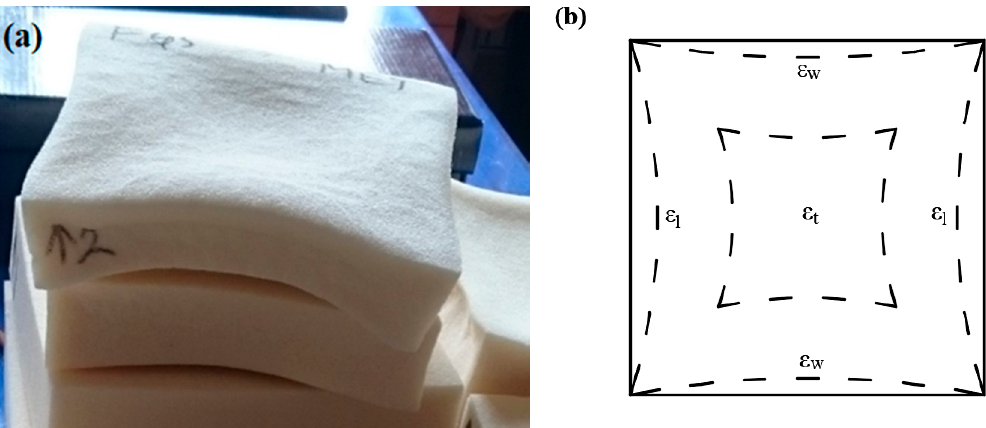
Figure 1. Polyurethane foam specimens: ( a ) after preparation for thermal conductivity tests and ( b ) graphical interpretation of dimensional changes.